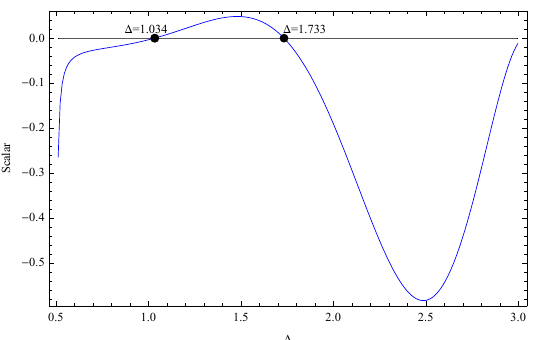
Figure 3 . Plot of the sum of all three channels for a scalar exchange as a function of the scalar dimension. This is mostly negative except for (cid:1) 2 (1 : 034 (cid:0) 1 : 733) where this (cid:13)ips sign and be- comes positive.